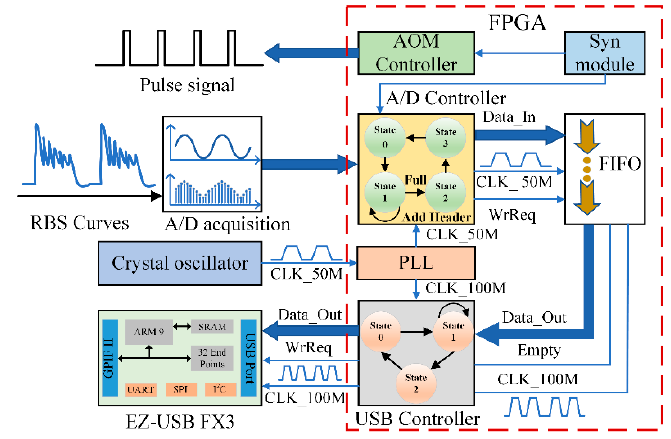
Figure 4. Functions of FPGA in Φ -OTDR sensing system.